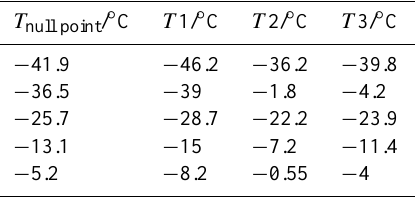
Table 1. Temperature gradients around the null point of the CEDB T null point / ◦